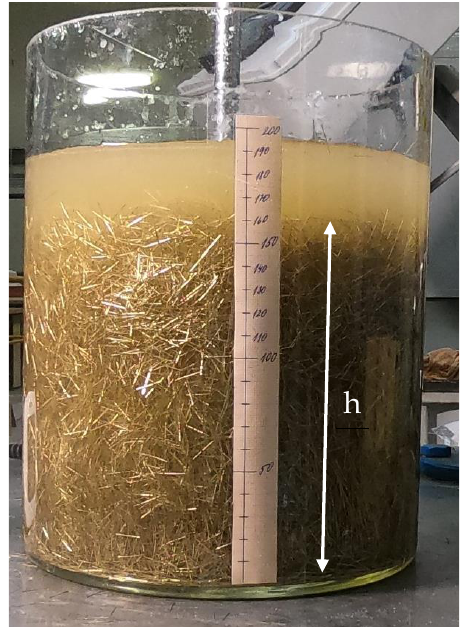
Figure 2. Layout of sedimentation test.